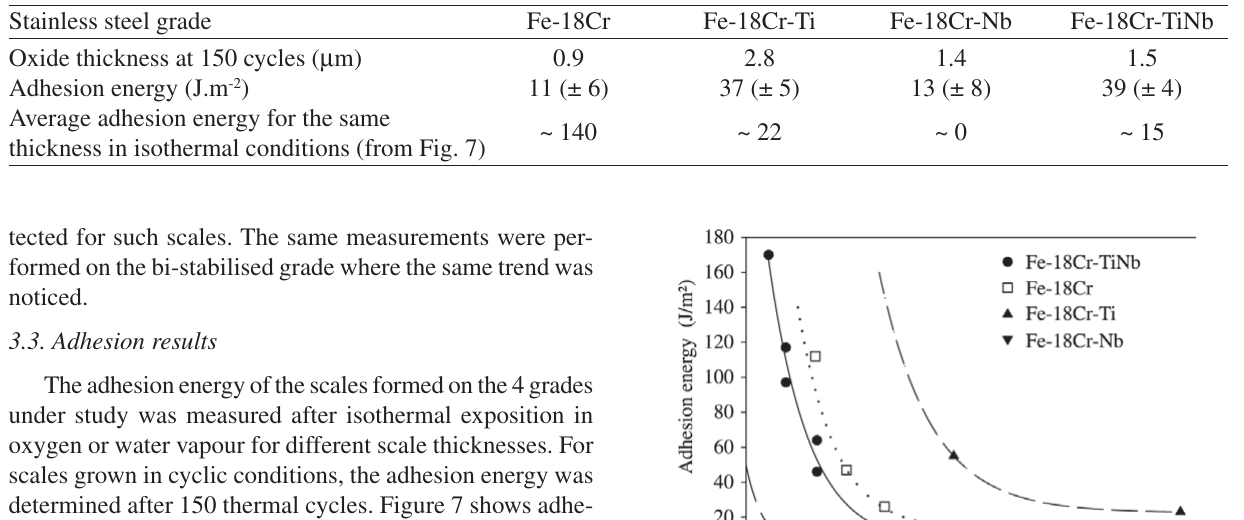
Table 3. Adhesion energy of oxide scales grown for 150 cycles and comparison with isothermally grown